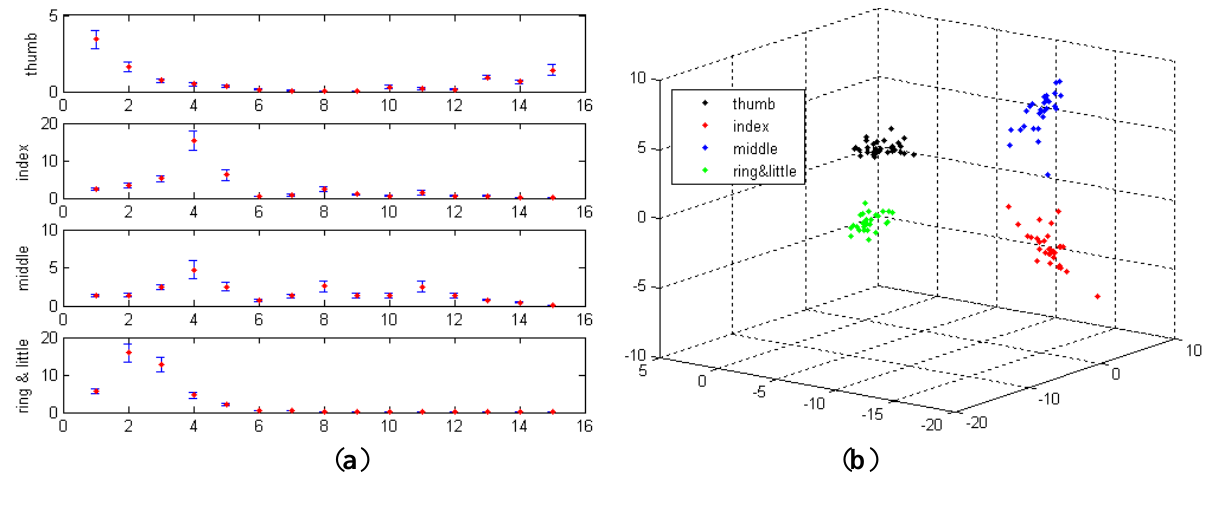
Figure 6. ( a ) Raw energy ratio features of the four gestures. ( b ) Projected energy ratio features of the four